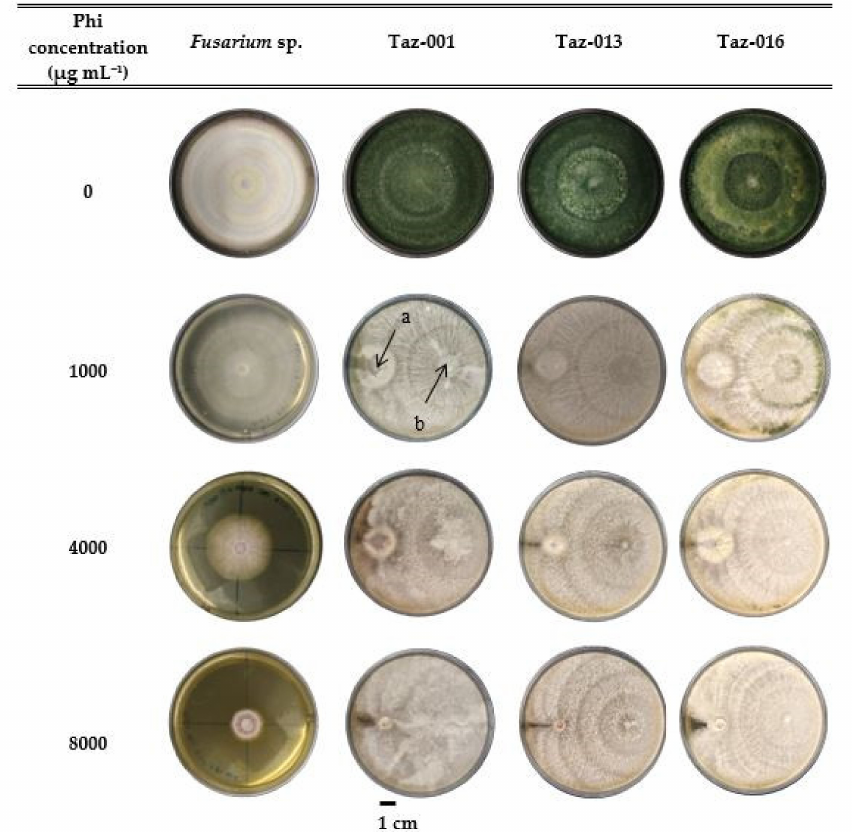
Figure 3. Growth of Fusarium sp. and Trichoderma sp. isolates after 10 d incubation in Petri dishes with three different Phi concentrations and a control without Phi. (a) Pathogen inoculation ( Fusarium sp.); (b) bioregulator inoculation ( Trichoderma sp.).